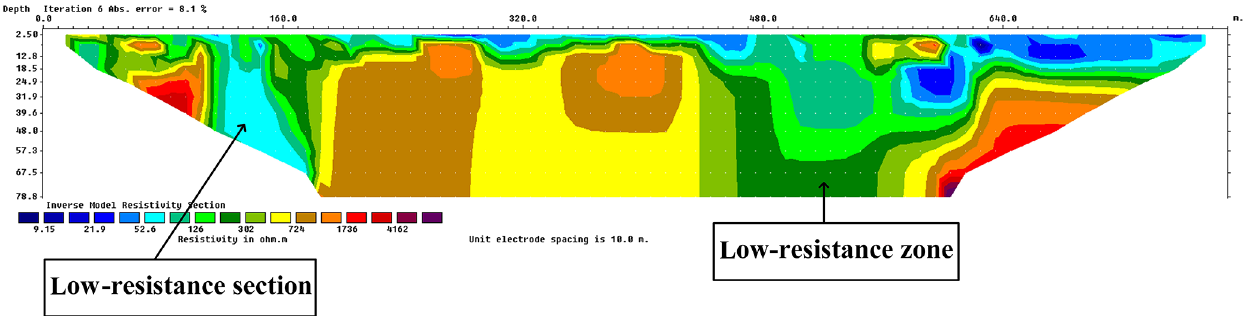
Figure 17. Profile view of survey line L3 obtained using the high-density electrical method.